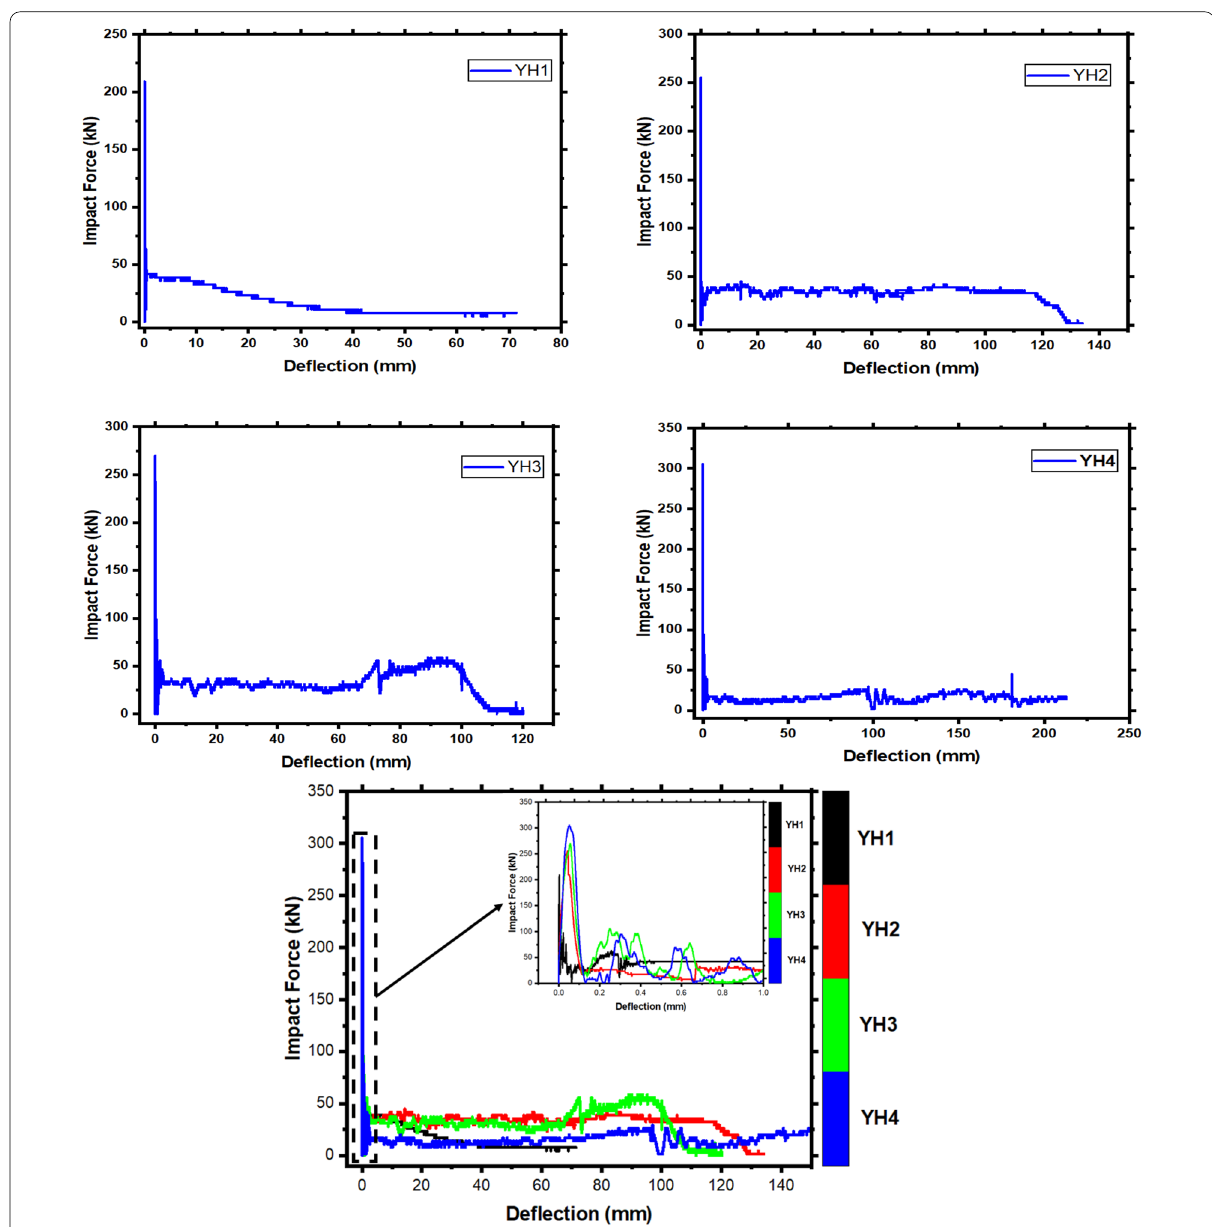
Fig. 15 Impact force–deflection